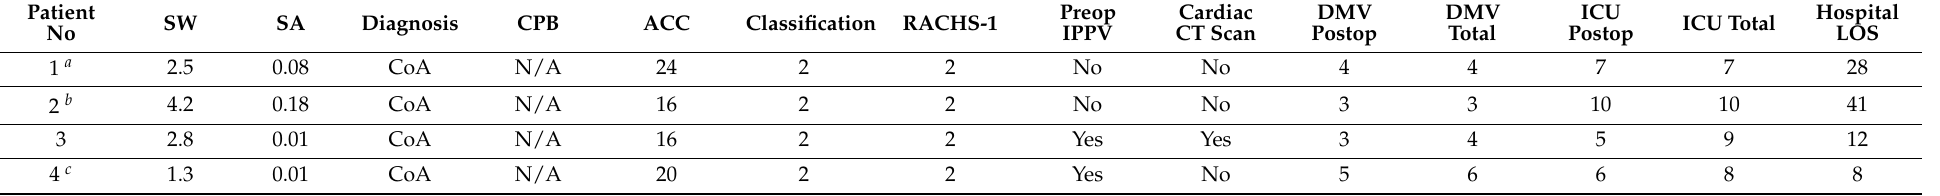
Table 7. Characteristics of patients with non-resolved